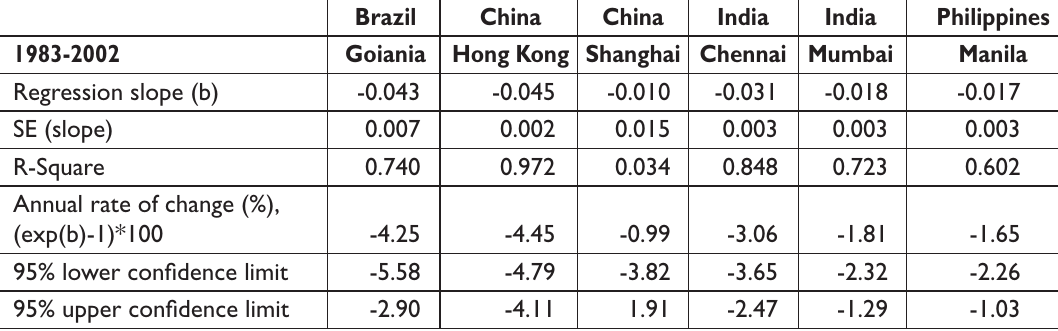
Log-Linear Regression Trend Models of Cervical Cancer Incidence, 1983-2002